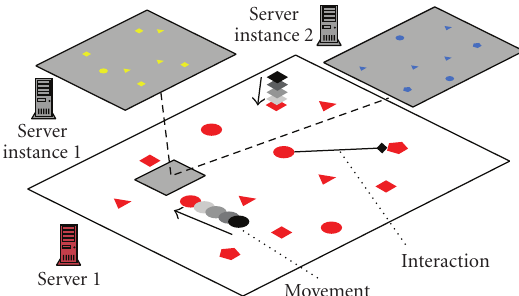
Figure 11: A virtual world with one instanced area processed independently by two servers.